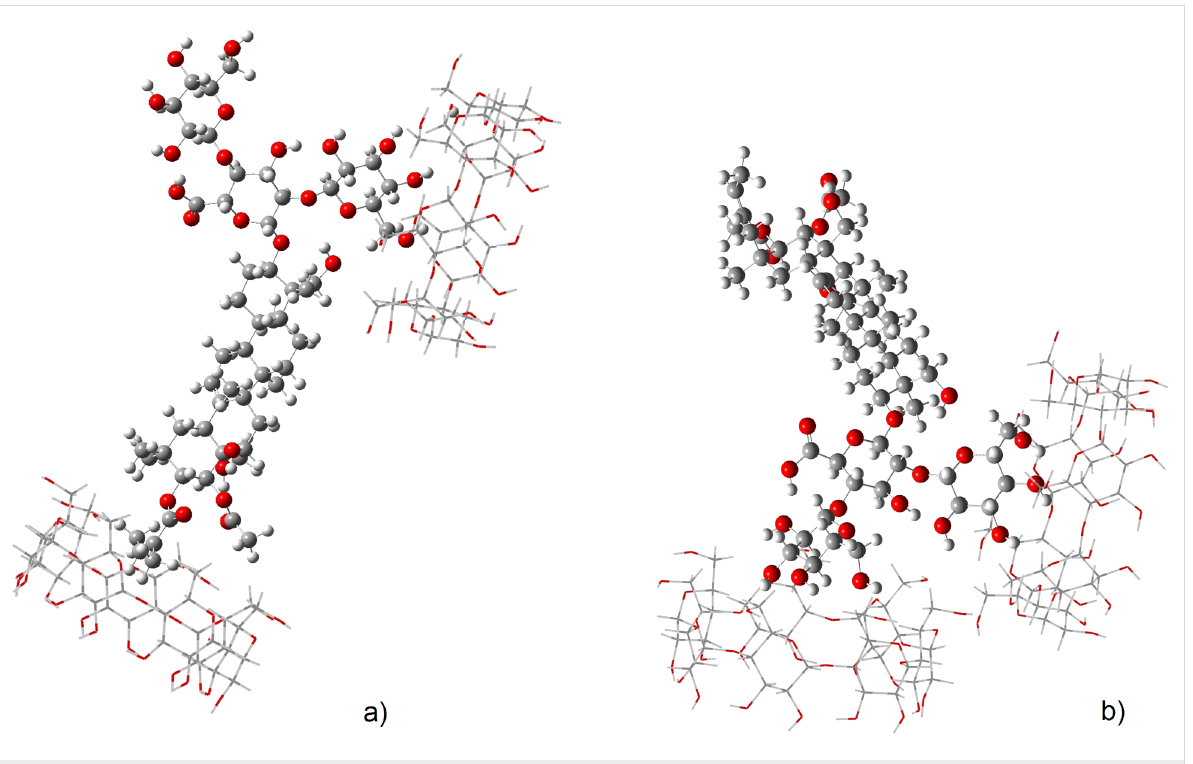
Figure 5: Carbon (and corresponding proton) numbering of